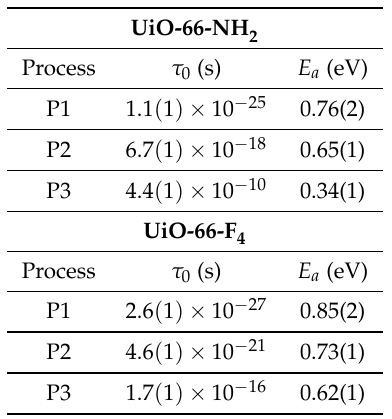
Figure 5. Inverse temperature dependence of the mean relaxation time of P1-P3 processes in hydrated UiO-66-NH and UiO-66-F MOFs. The lines are linear fits to the Arrhenius equation. 2 4 Table 1. Attempt time and activation energy for different processes in hydrated UiO-66-NH UiO-66-F 4